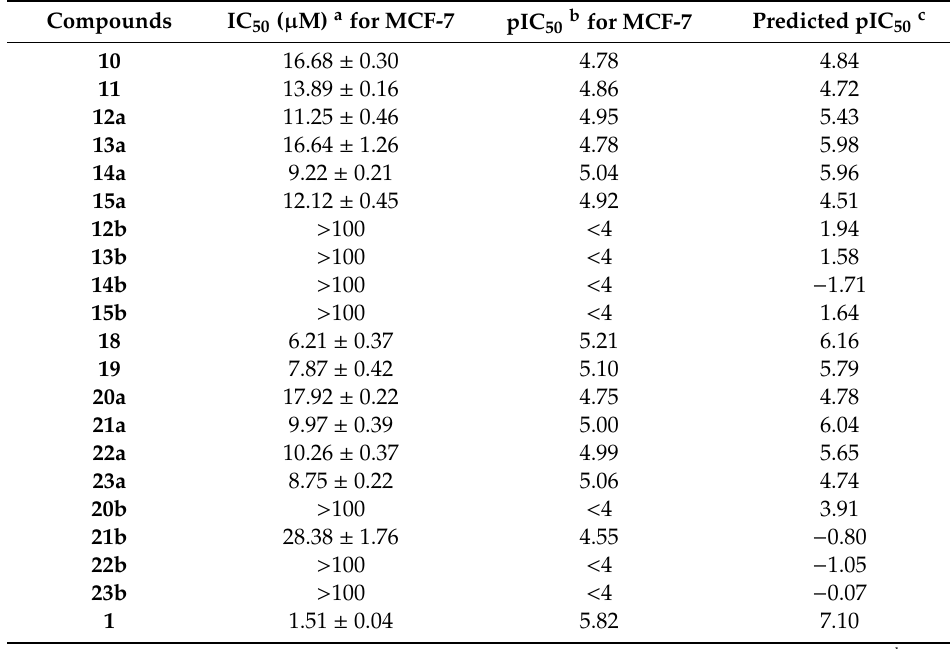
Table 2. Comparison of predicted pIC 50 by 3D QSAR with experimental values.